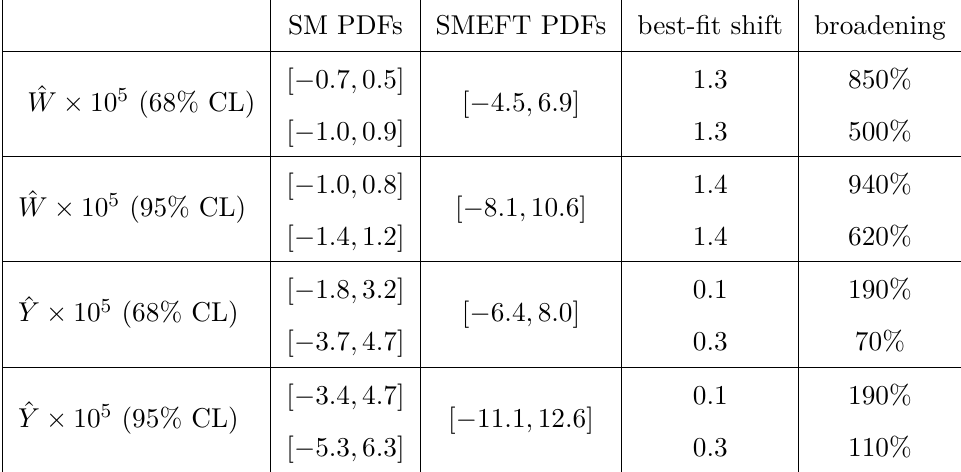
Table 6 . Same as table 4 for the 68% CL and 95% CL marginalised bounds on the ˆ W and ˆ Y parameters obtained from the two-dimensional ( ˆ W , ˆ Y ) fits that include the HL-LHC pseudo-data for NC and CC Drell-Yan distributions. As in table 4, for the SM PDFs we indicate the bounds obtained without (upper) and with (lower entry) PDF uncertainties accounted